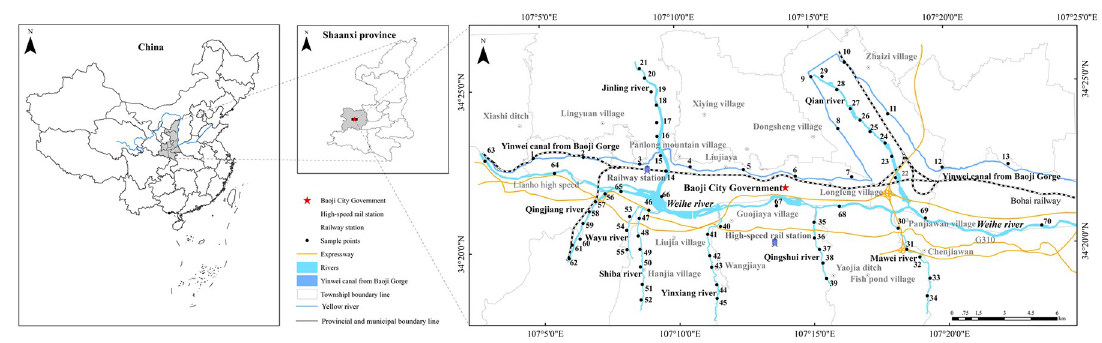
Fig 2. Sampling point layout.